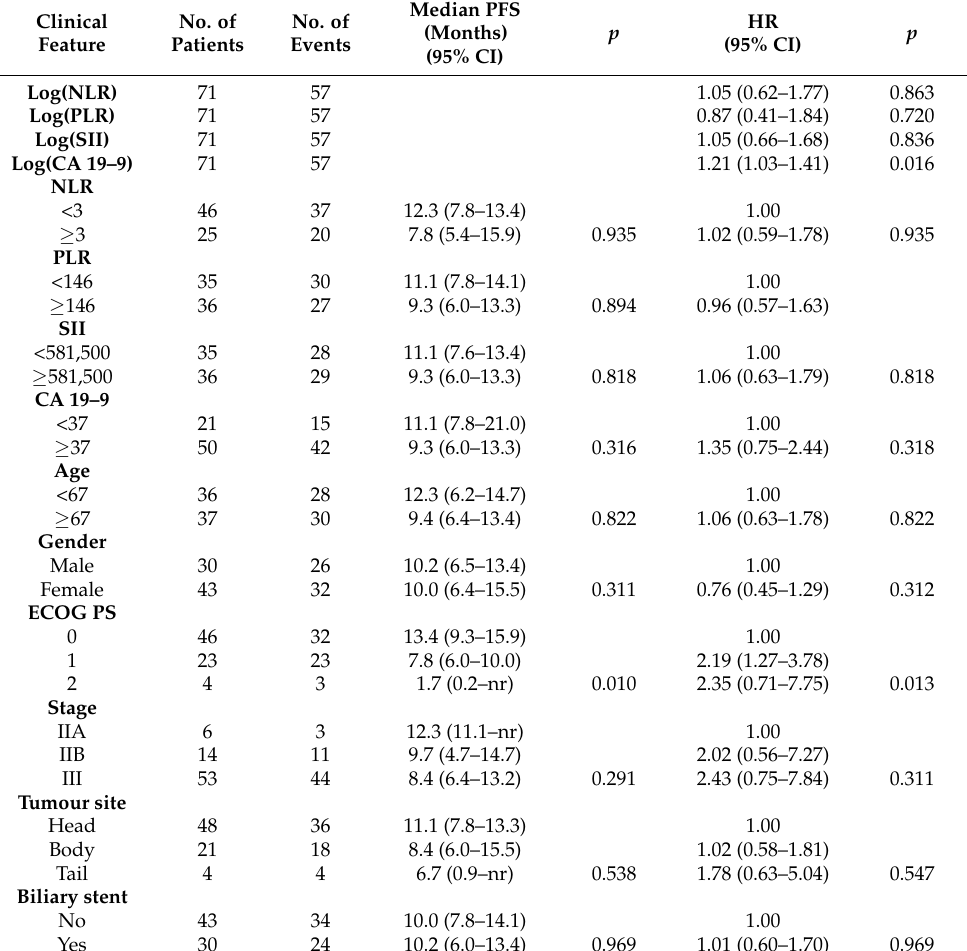
Table 5. Univariate analysis of progression-free survival.